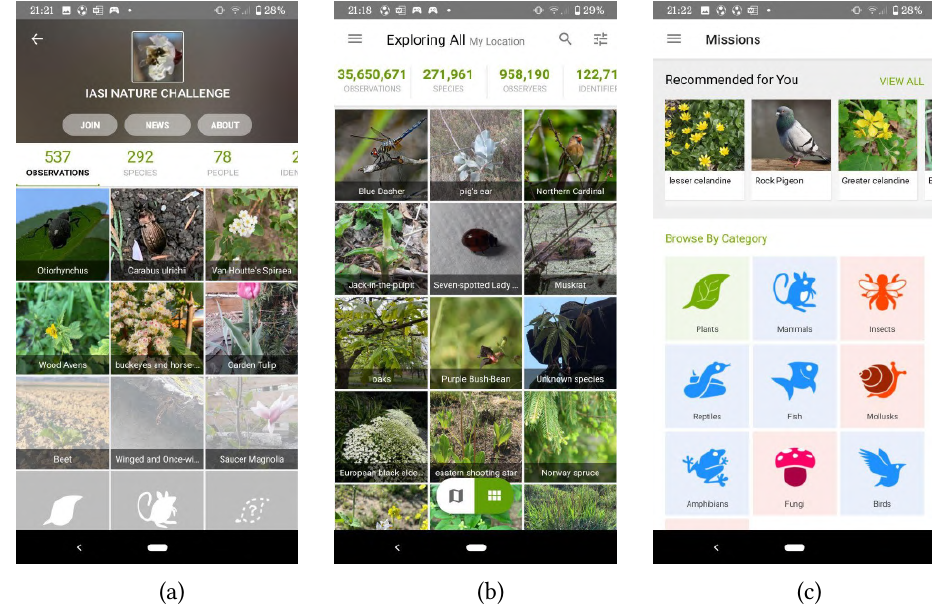
Figure 6: The Exploring All (a), Missions functions (b) and concrete project (c) functions.